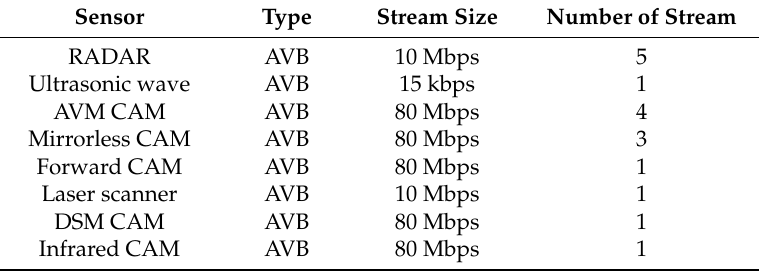
Figure 5. IVN model for autonomous driving vehicle. Table 3. Background stream for advanced driving assistant system (ADAS) sensor fusion.